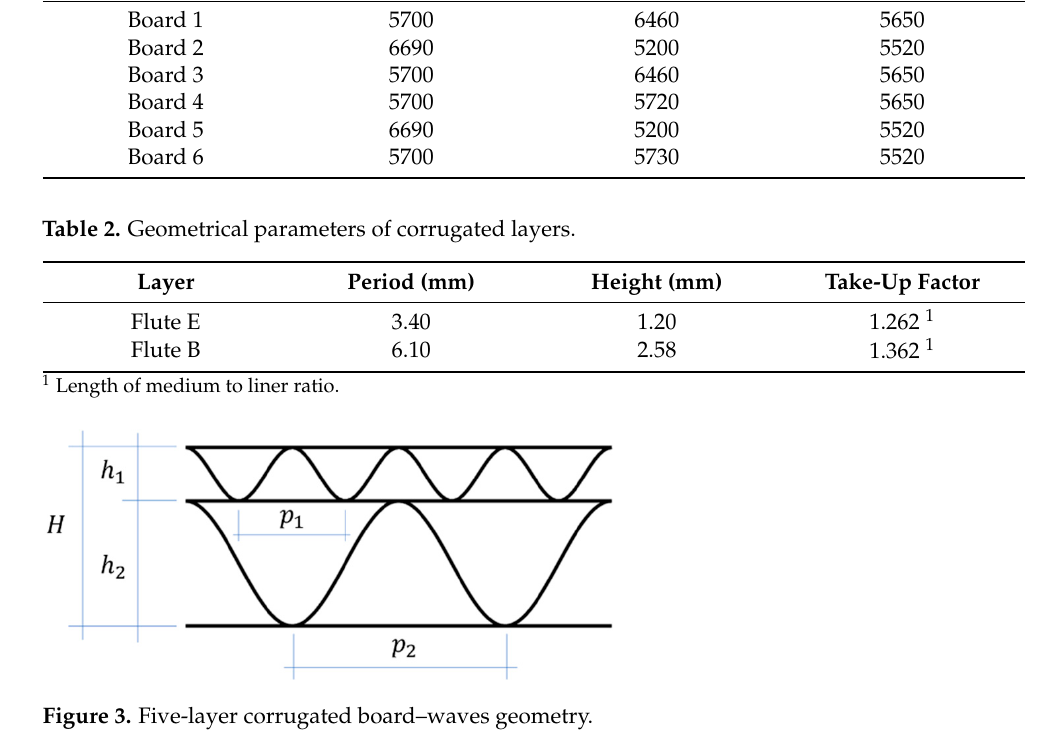
Table 1. Stiffness moduli for individual flat layers of corrugated board.